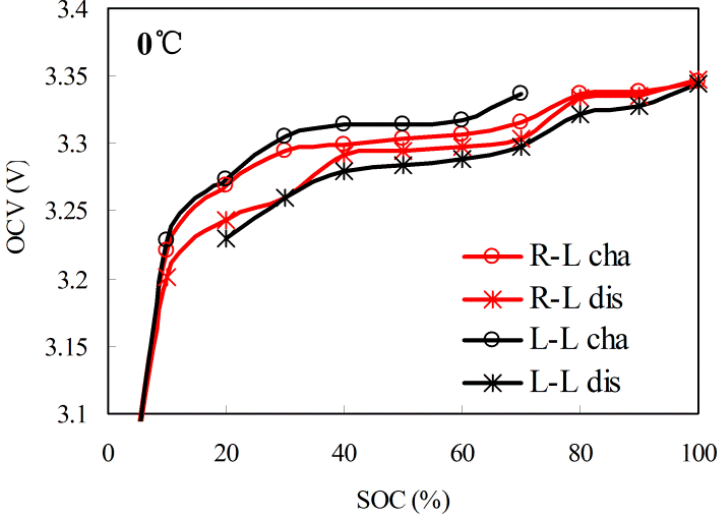
Figure 12. Charged and discharged OCV–SOCs in different temperature